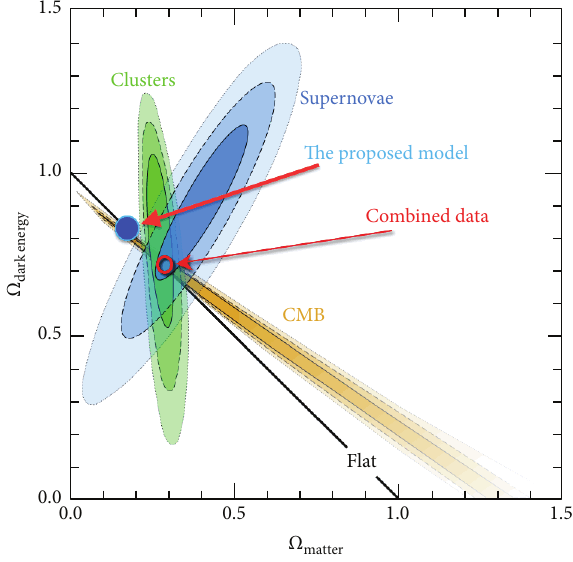
Figure 4: Existing observational data on dark energy/matter split from various sources displaying the current consensus that relies on constant 𝐺 - Λ cosmology as well as the proposed variable 𝐺 - Λ cosmology. Adapted from http://www.hep.ucl.ac.uk/darkMatter/.